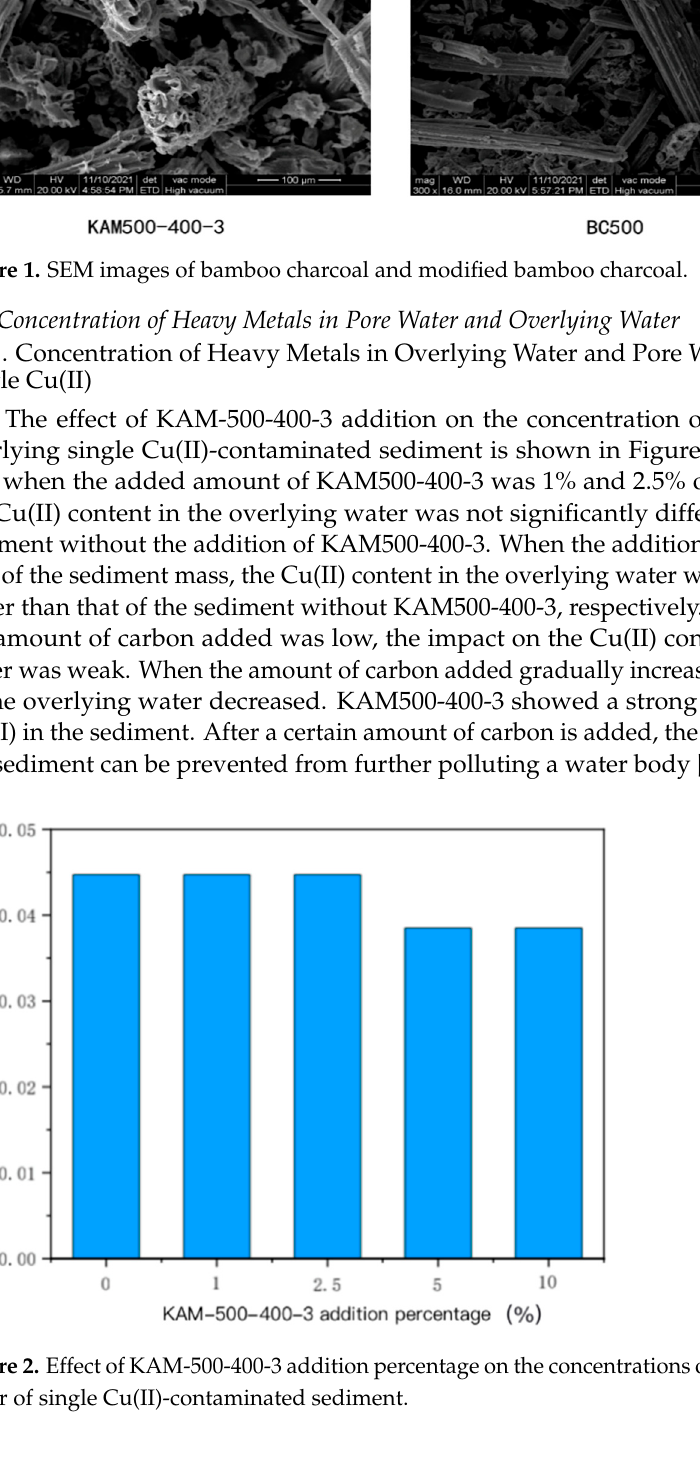
Figure 3. Effect of KAM-500-400-3 addition percentage on the concentrations of Cu(II) in the pore water of single Cu(II)-contaminated sediment. 3.2.2. Concentration of Heavy Metals in Overlying Water and Pore Water of Cu(II)– Cd(II) Mixed Polluted Sediment The experimental results showed that Cd(II) was not detected in the overlying or pore water of mixed Cu(II)–Cd(II)-contaminated sediment. This may have been because the content of Cd(II) was too low, so the degree of pollution of the overlying and pore water was low [28,29]. The effect of the amount of KAM-500-400-3 added on the concen- tration of Cu(II) in the overlying water of mixed Cu(II)–Cd(II)-contaminated sediment is